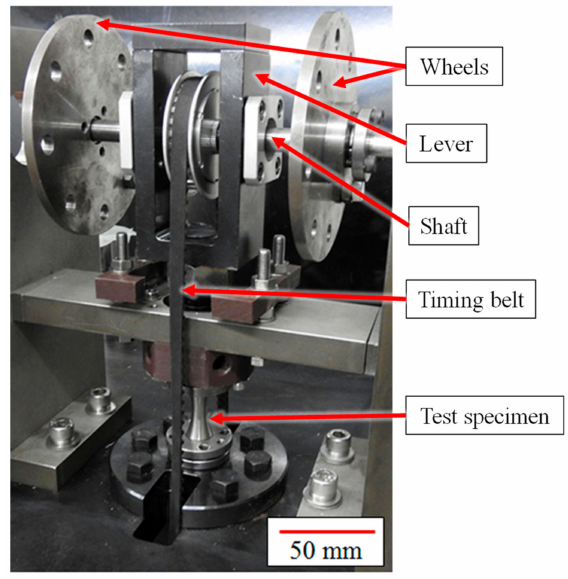
Figure 1. Photo image of the testing